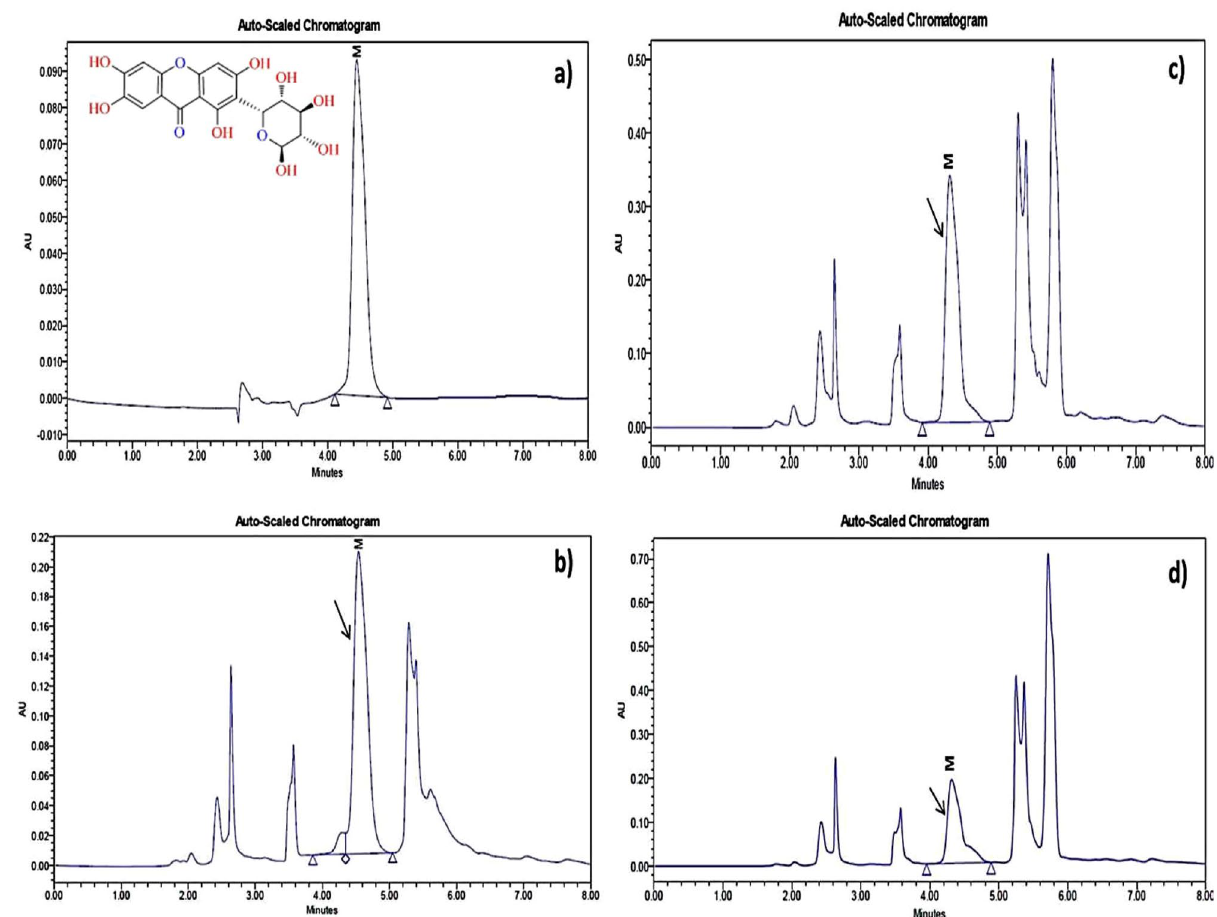
Figure 6. HPLC chromatogram of a mangiferin: standard compound ( a ) whereas ( b ), ( c , d ) represents HPLC chromatograms obtained from S. chirata samples prepared with ultrasound-assisted extraction